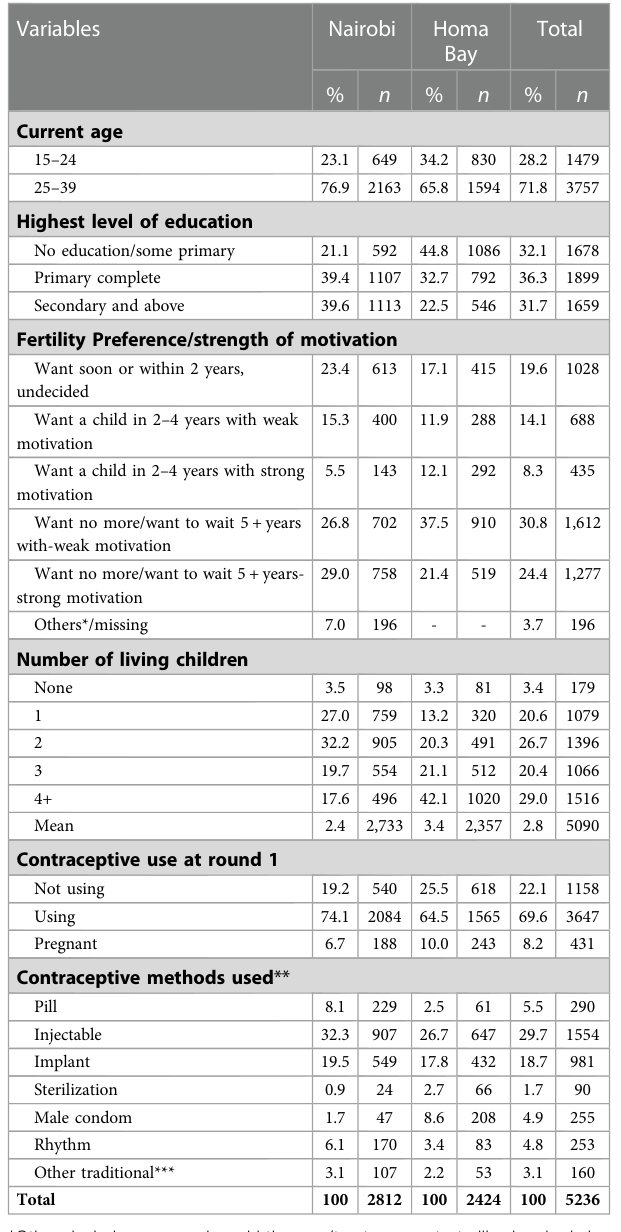
TABLE 1 Percent distribution of married or cohabiting women aged 15 – 39 years at round 1 in the two sites by background characteristics, Kenya